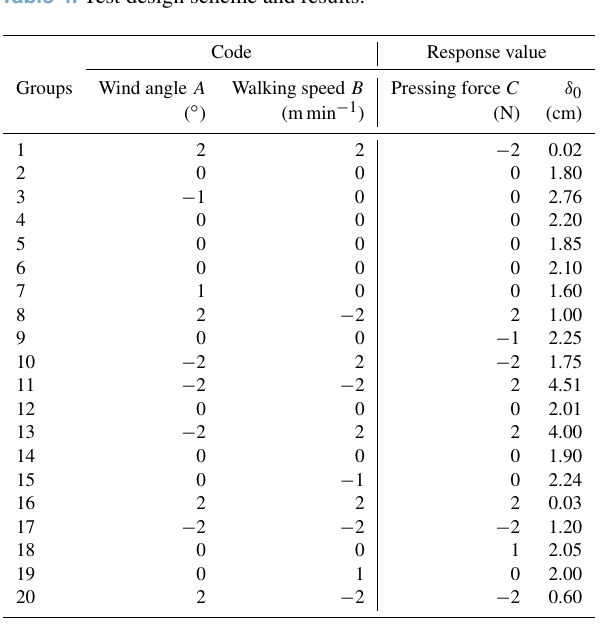
Table 4. Test design scheme and